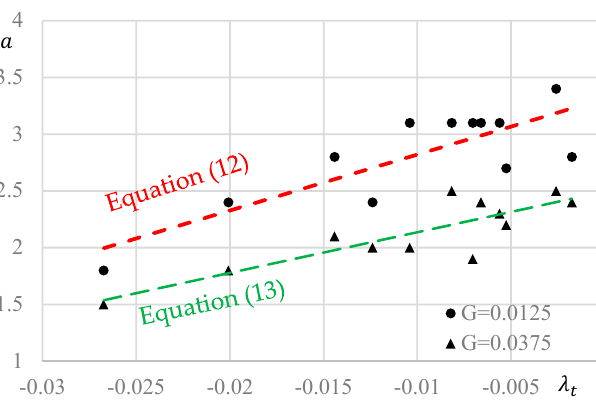
Figure 6. Variations of 𝑎 versus 𝜆 (cid:3047) for 𝐺 = 0.0125 and 𝐺 = 0.0375 .